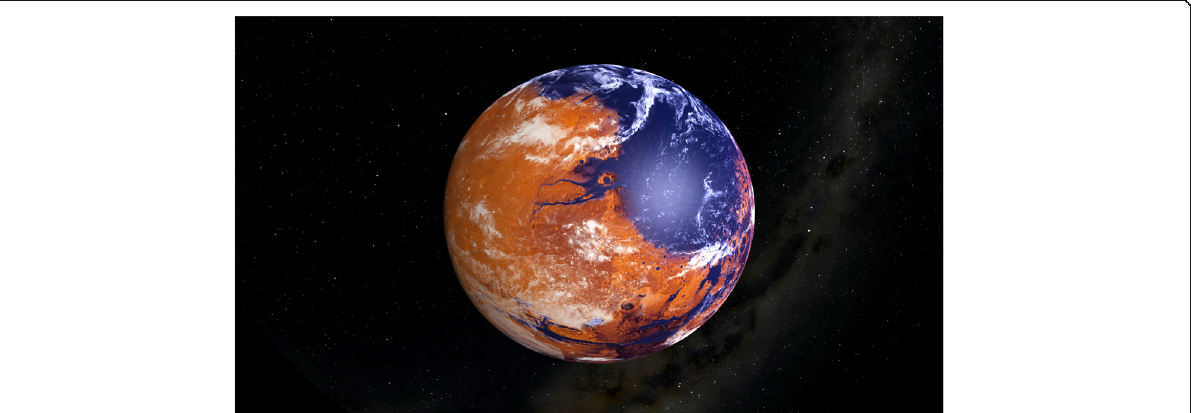
Fig. 1 Rendition of the ancient ocean occupying nearly half of Martian northern hemisphere (NASA ’ s Goddard Space Flight Center public domain